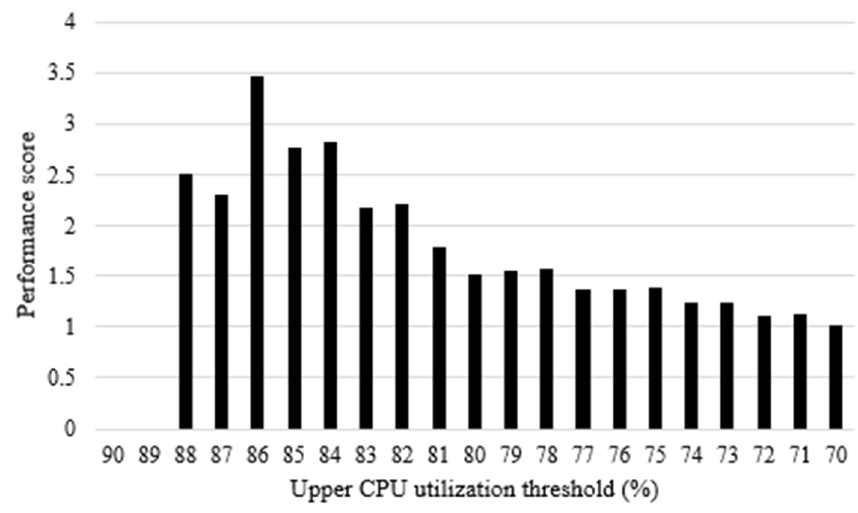
Figure 7. Performance score according to each upper CPU utilization threshold.